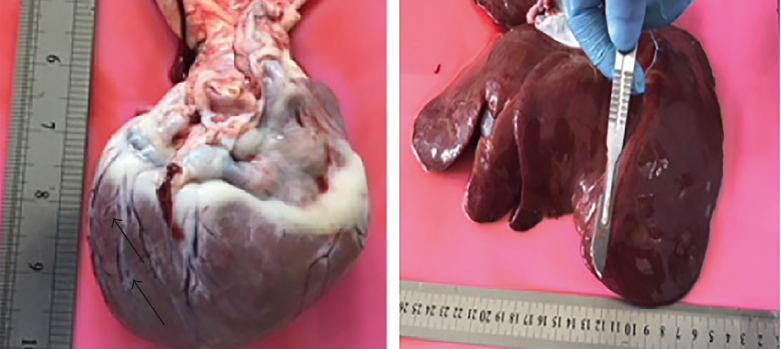
Figure 6: Gross pathological lesions on the heart and liver of dogs given cumulative dose of free DOX 150mg/m 2